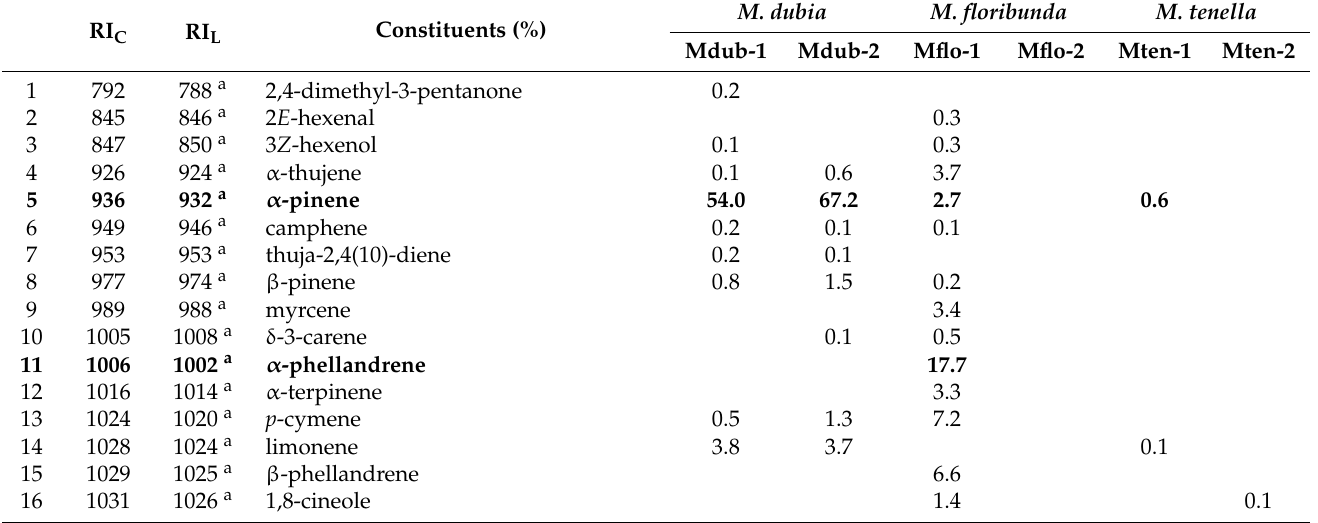
Table 1. Yield and composition of essential oils from Myrciaria species